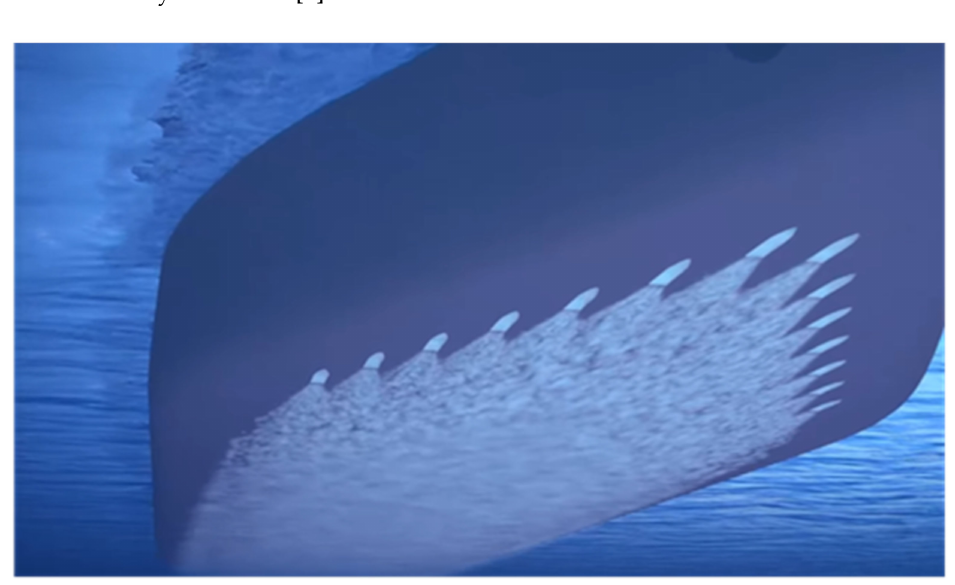
Figure 12. Silverstream Technologies’ arrow-formation of injectors.